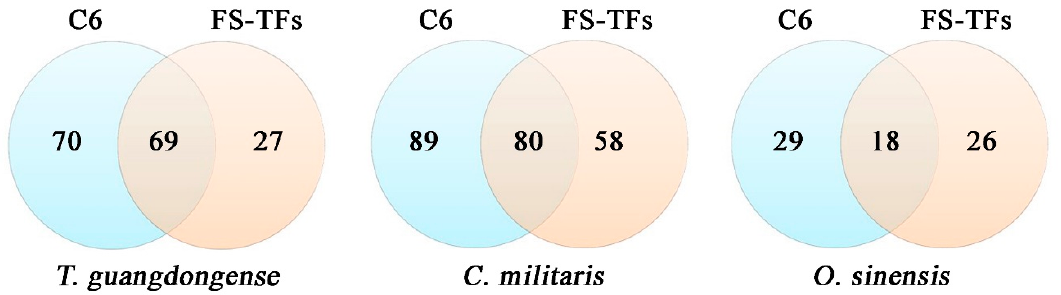
Figure 1. Estimates of C6 zinc genes and fungal specific transcription factors (FS-TFs) in Tolypocladium guangdongense , Cordyceps militaris and Ophiocordyceps sinensis genomes by automatic and manual analyses. The detail information was shown in Table S2.